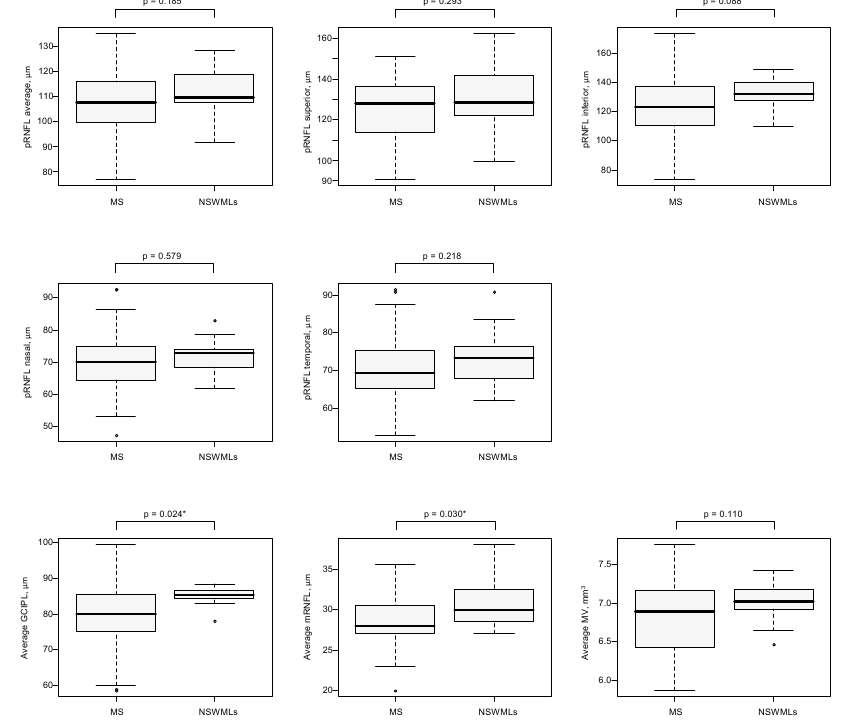
Figure 3. The boxplots of OCT parameters measured in MS and NSWMLs groups. Abbreviations: MS, multiple sclerosis; NSWMLs, nonspecific white matter lesions; pRNFL, peripapillary retinal nerve fiber layer; GCIPL, ganglion cell inner plexiform layer; mRNFL, macular retinal nerve fiber layer; MV, macular volume. p values were obtained from the Mann–Whitney U test for continuous variables and χ 2 test or Fisher exact test for nominal variables. * indicate significant difference ( p ≤ 0.05).